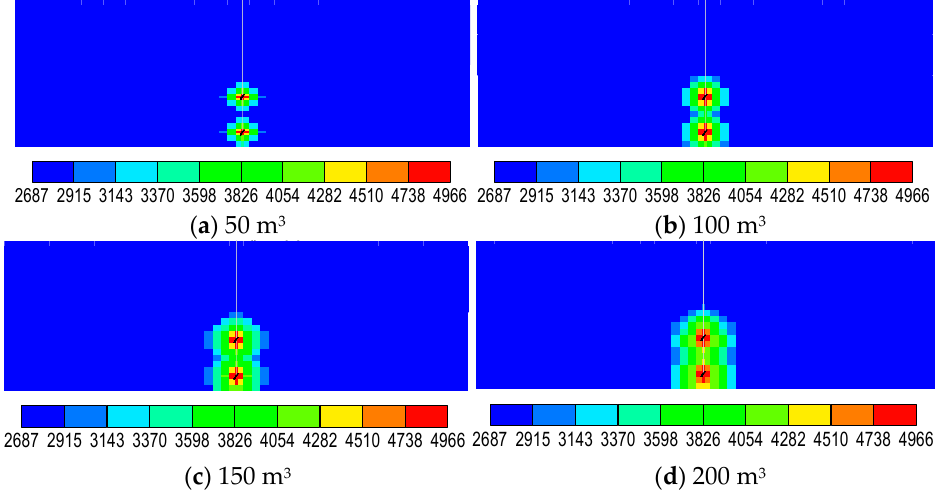
Figure 5. Comparison of pressure profiles at different water injection (Color bar: Pressure, KPa; ( a – d ) subfigure means the pressure profile after injecting 50, 100, 150, 200 m 3 of water, respectively).